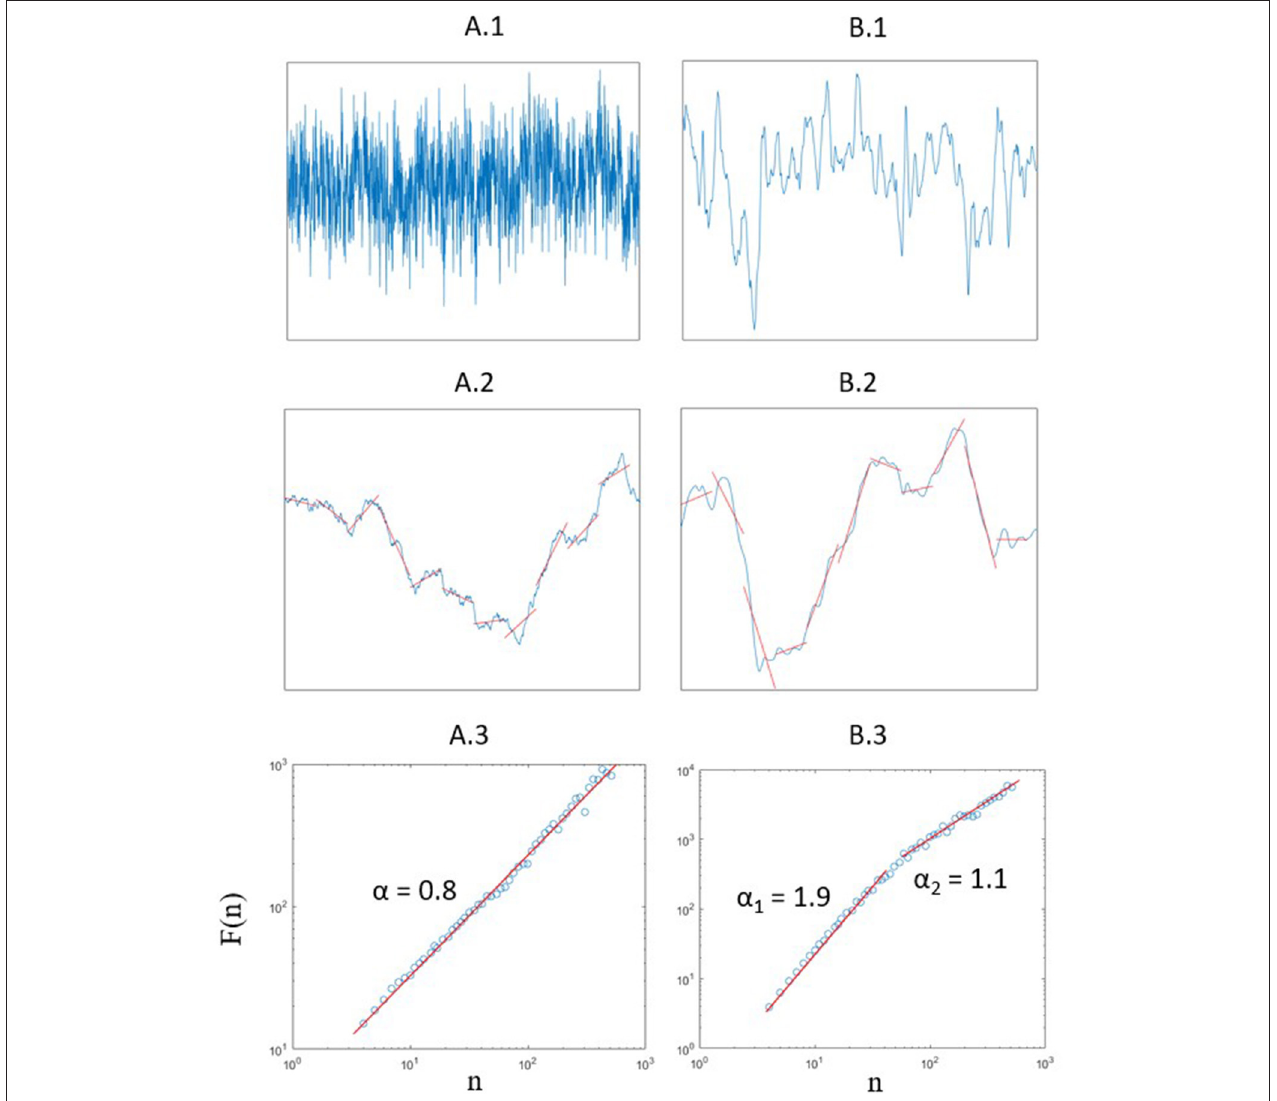
FIGURE 1 | (A.1) Artificial fractal signal with α = 0.8 (Generated using Davies and Harte method Davies and Harte, 1987. (A.2) Example of a detrending for a fixed value of n = 181 of the artificial signal after integration. (A.3) Fluctuation function and value of α obtained by the slope of the curve. (B.1) Typical position signal obtained for the displacement of COP along the AP axis. (B.2) Example of a detrending for a fixed value of n = 181 of the typical signal after integration. (B.3) Fluctuation function: at least two different scalings are observed here. Note that both DFA show F(n) vs. n in a log-log